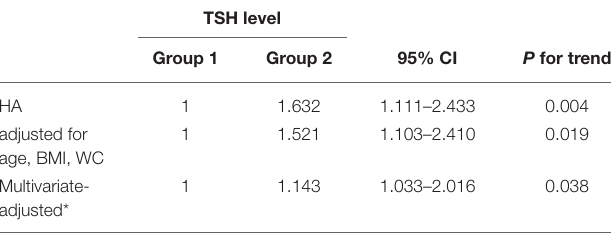
TSH ≤ 4.0 mU/L; Group S2, 4.0 < TSH ≤ 5.0 mU/L). TABLE 3 | Associations of TSH level with HA in PCOS